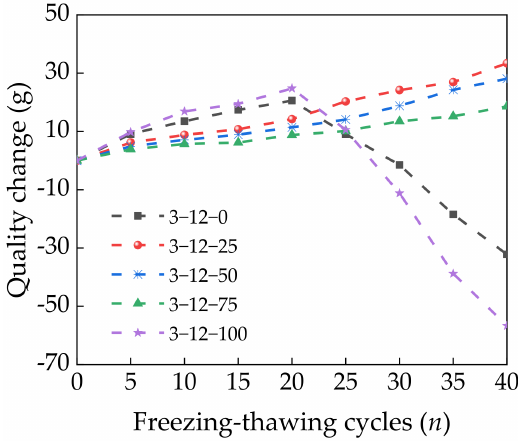
Figure 9. Changes in specimen quality with freeze–thaw